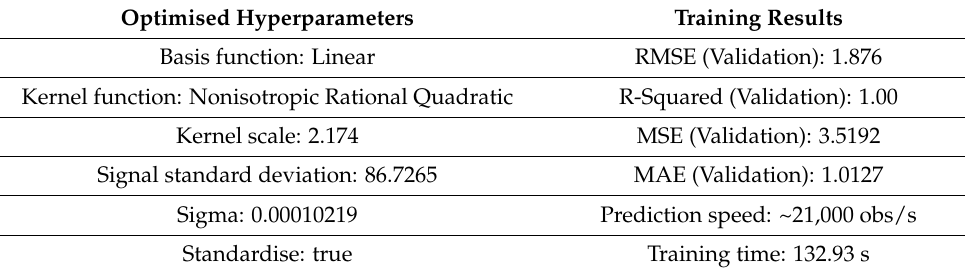
Table 3. Hyperparameters of the Gaussian process regression model.